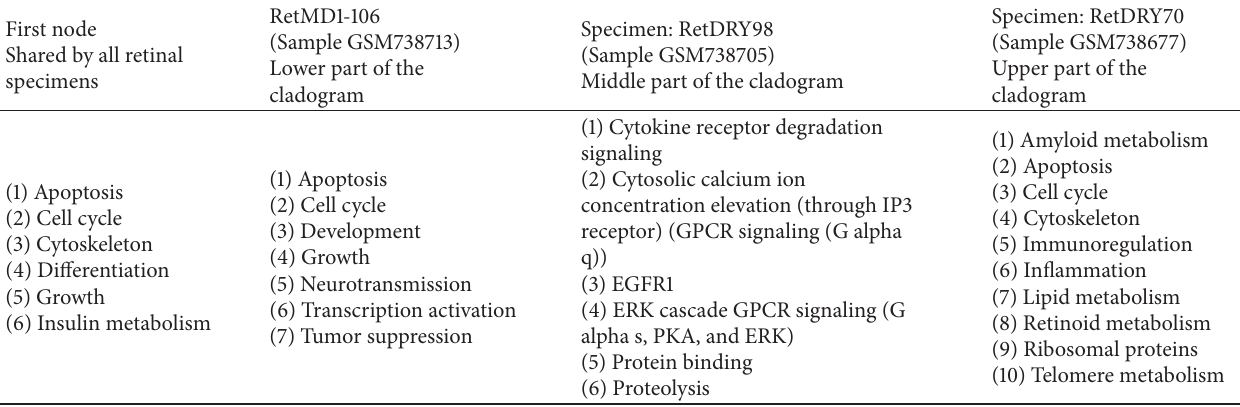
Table3:AffectedretinalsignalingpathwaysatdifferentlocationsofcladograminFigure 1.Sampleidentificationfollowshttp://www.ncbi.nlm .nih.gov/geo/query/acc.cgi?acc=GSE29801.